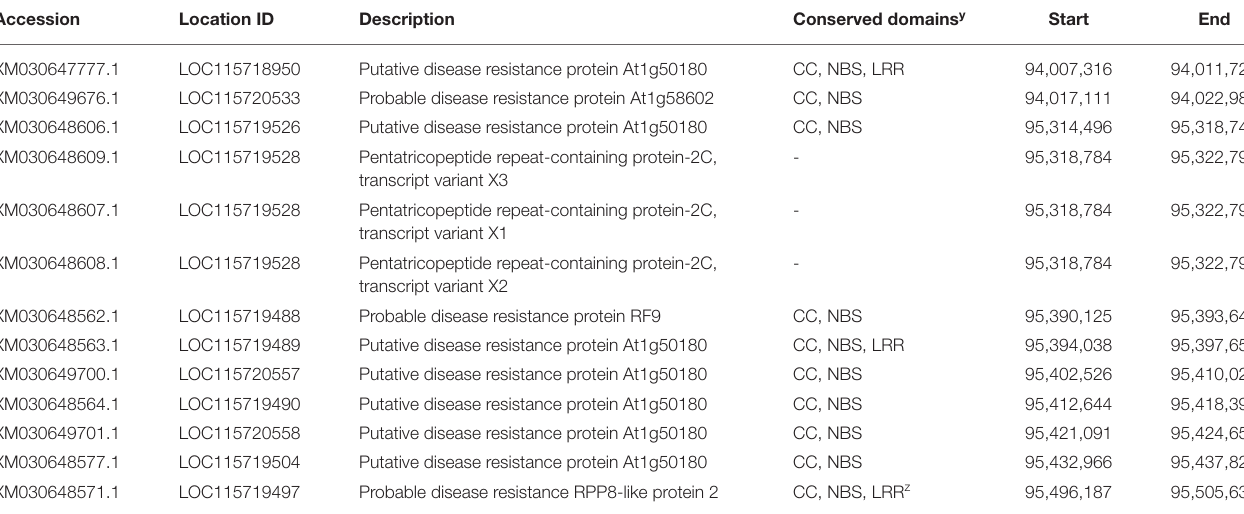
TABLE 2 | Annotated resistance-like genes on chromosome 2 of the Cannabis sativa “CBDRx” genome surrounding the location of the LH3804 locus.